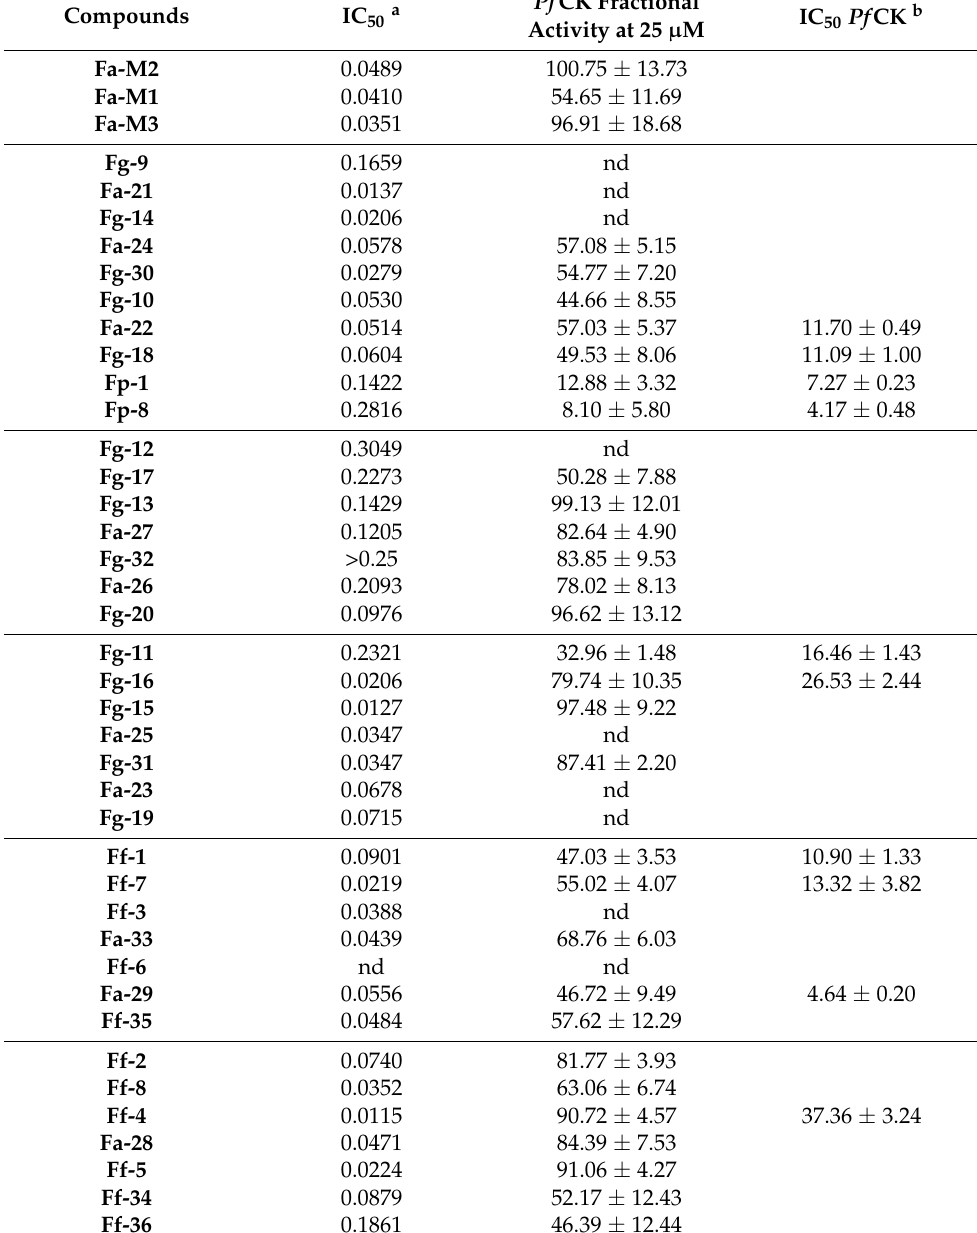
Table 2. In vitro inhibitory effects of final